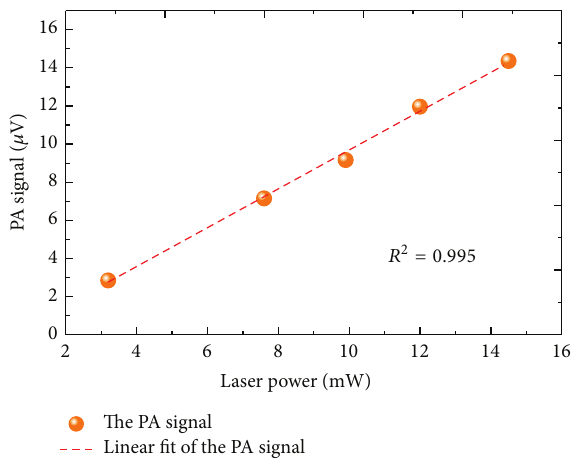
Figure 9: The PA signal versus CO concentration ranging from 300 to 2000 𝜇 L/L.